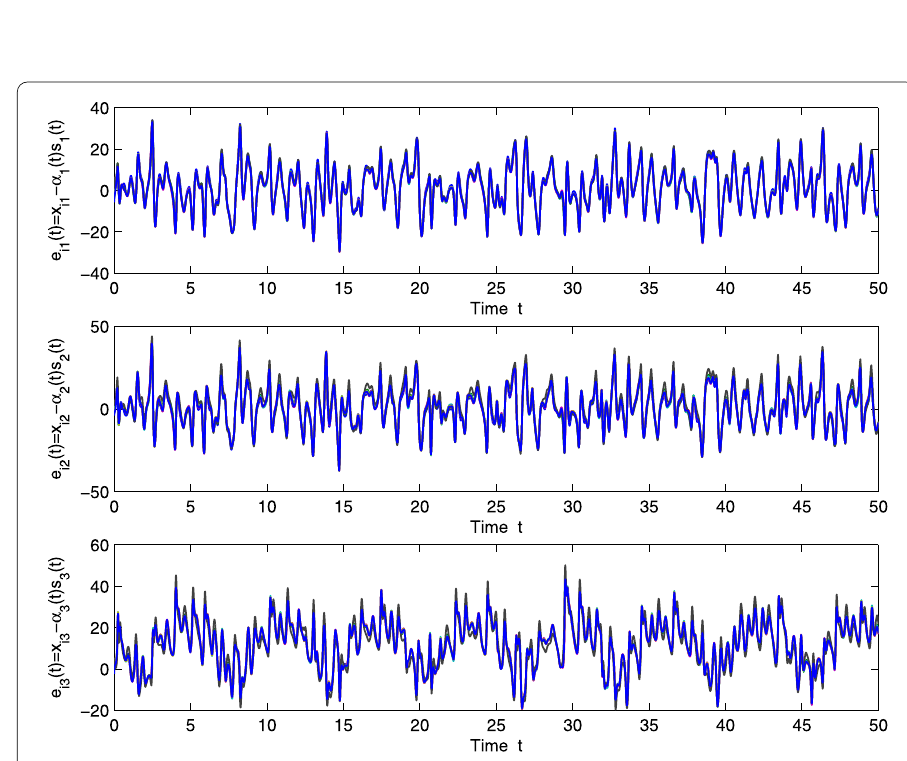
Figure 9 Chaotic behavior of drive system (40) and response network (41) with the time-varying scaling function matrix α ( t ) = diag(0.45 e sin( t ) ,0.5 e sin( t ) ,0.4 e sin( t ) ).